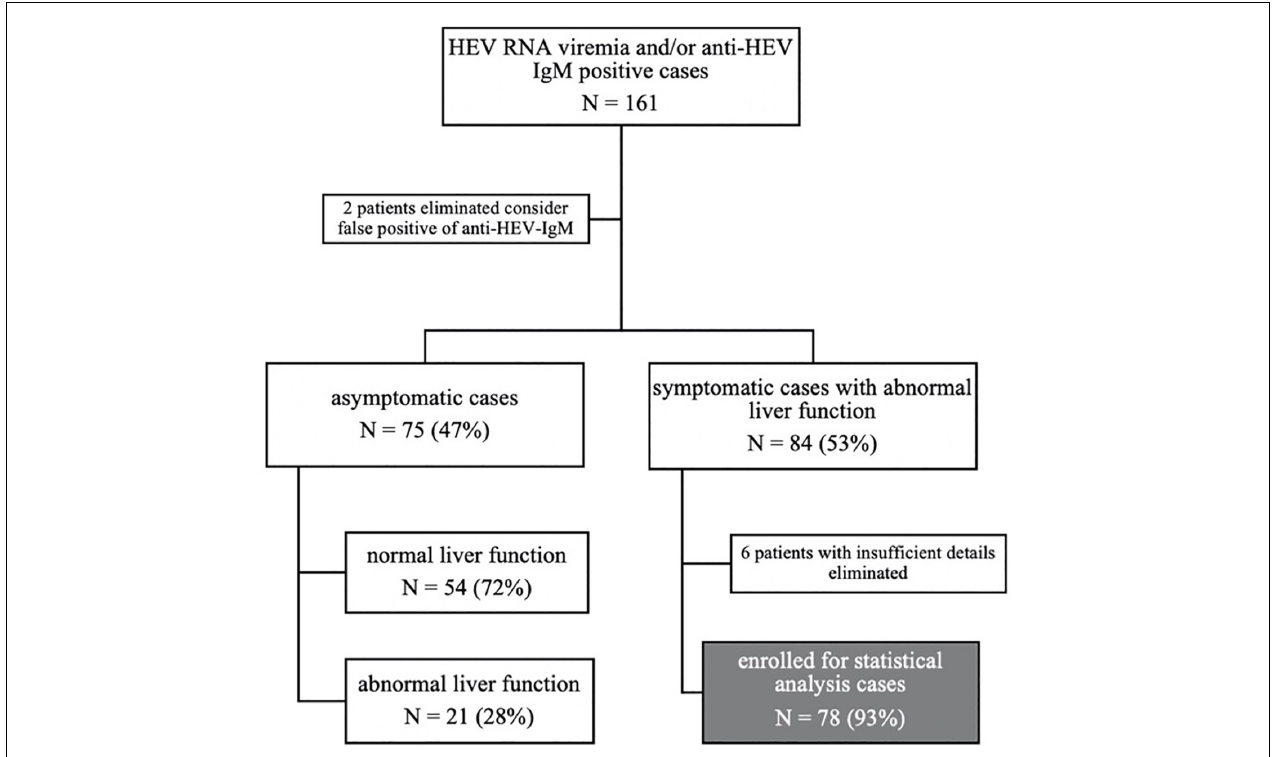
FIGURE 3 | Flow diagram: study participants were grouped according to symptoms, liver function, and the final enrolled populations for our